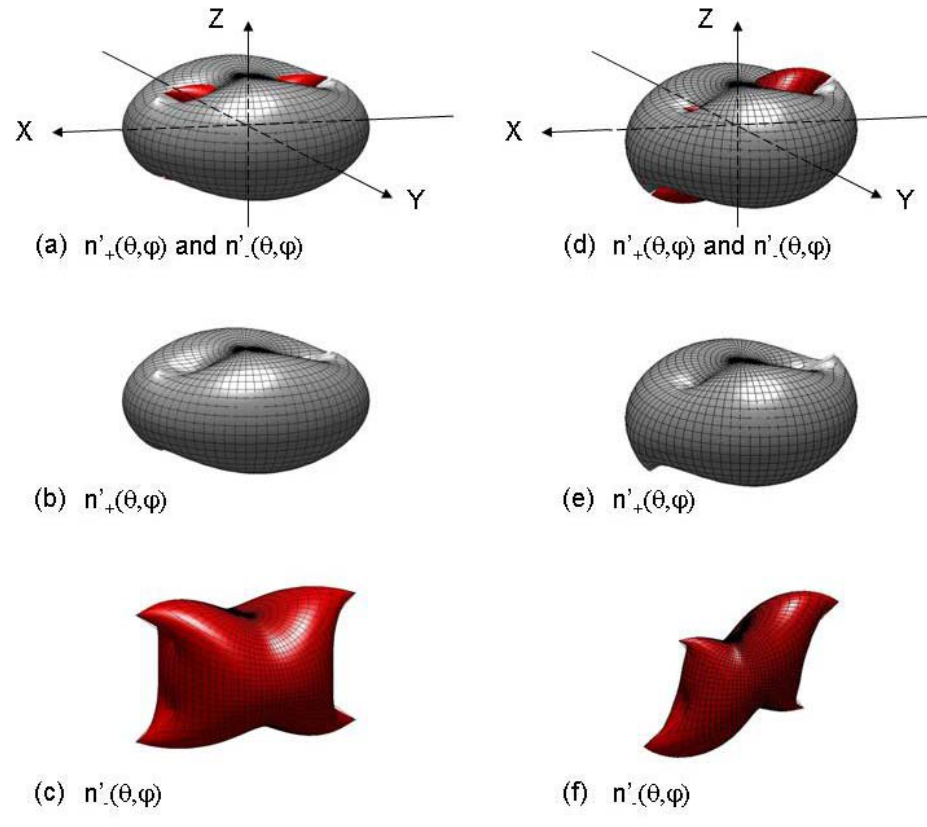
Figure 1. Numerical calculations of angular distributions of luminescence or absorption properties in the dielectric frame (X, Y, Z) of biaxial crystals from the orthorhombic {(a)- (b)-(c)} and monoclinic {(d)-(e)-(f)} crystal systems; (a)-(d) double-layer surface composed of ' ( , ) n θϕ and ' ( , ) n θϕ , showing remarkable layer-inversion zones; (b)-(e) and + − (c)-(f) single layers related to ' ( , ) n θϕ and ' ( , ) n θϕ , + −